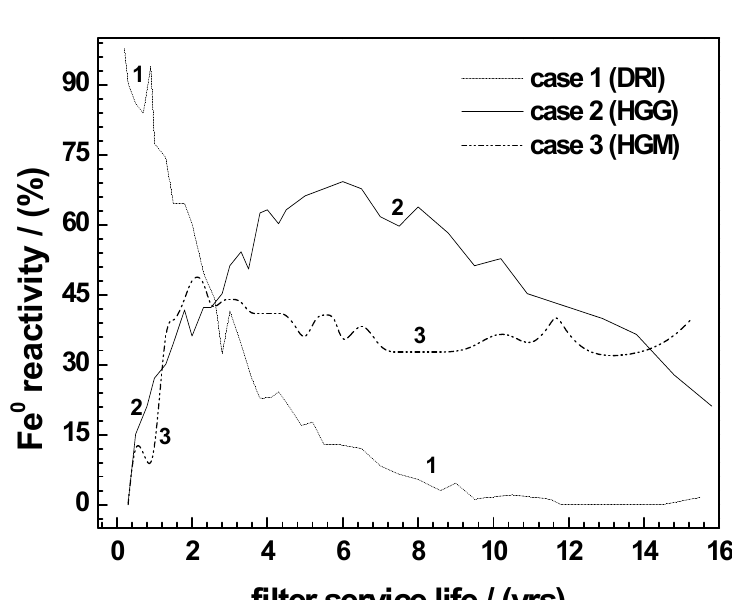
Figure 5. Idealized relative reactivity of Fe 0 materials as a function of the reactive barrier service life. The three scenarios are deduced from the reactivity of DRI, HGG, and HGM for H 2 production in H 2 SO 4 (pH 2). For illustration purposes, the elapsed time was changed from hours to years, and the normalization of the reactivity was done